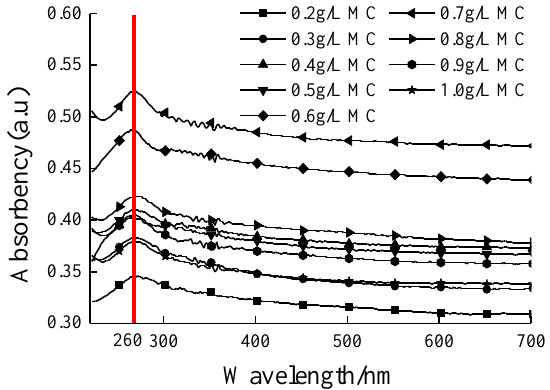
Figure 1. Ultraviolet visible spectroscopy (UV-Vis) absorbance spectra of graphene nanoplatelet (GNP) suspension with different methylcellulose (MC) concentrations.